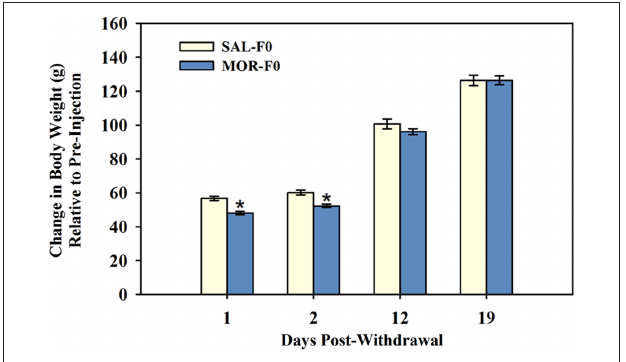
Figure 1 | Mean ( ± SeM) body weight gain (gram) following cessation of daily injections. * p < 0.001 as compared to SAL-F0 within day. N = 27 SAL-F0; N = 28